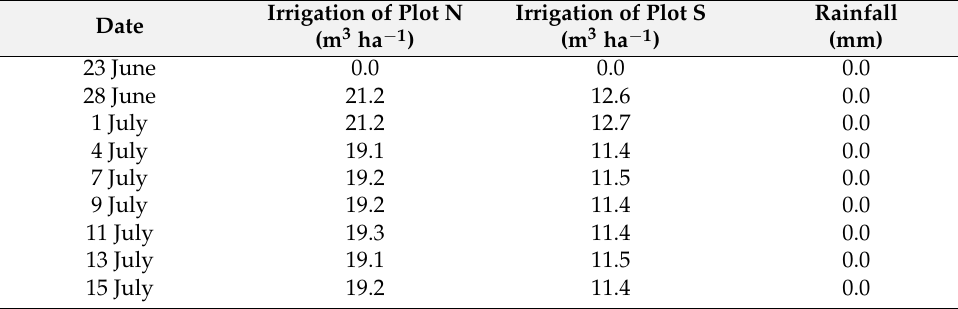
Table 1. Irrigation and rainfall during the trial